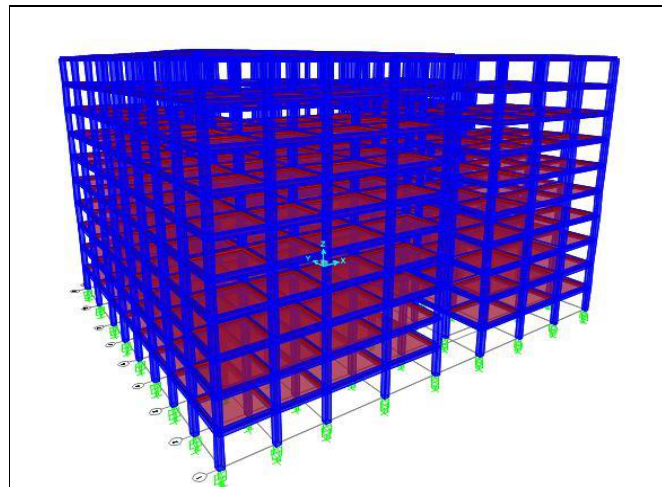
Figure 3: Base-Isolated Building